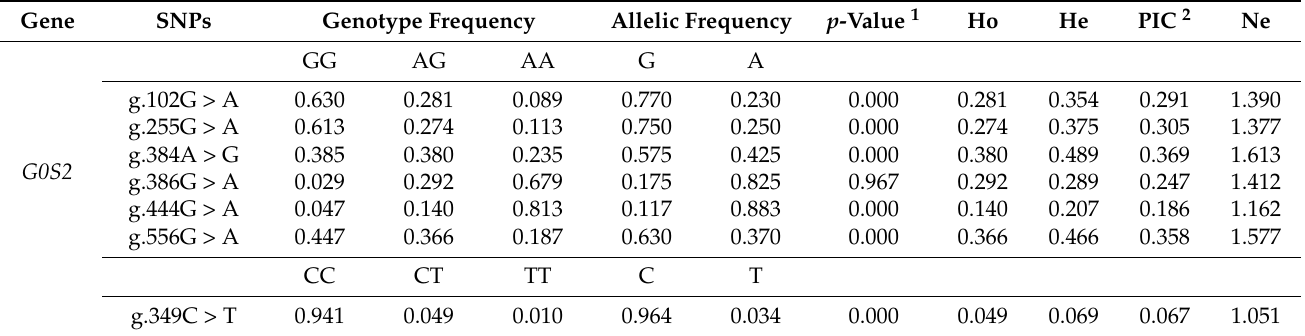
Table 2. The genotype frequency, allele frequency and diversity parameters of G0S2